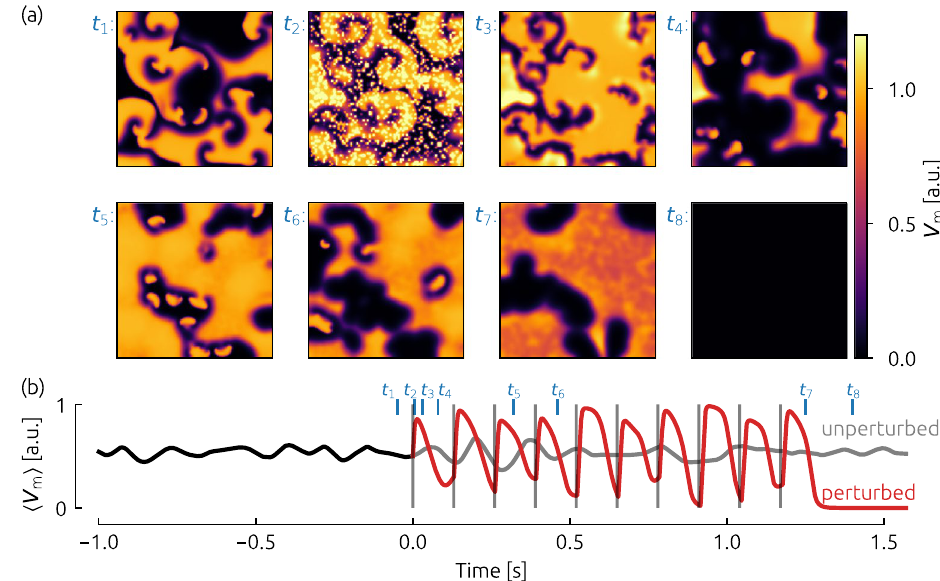
Figure 2. Exemplary (successful) termination attempt based on the Fenton-Karma model (FK) by a sequence of ten pulses. The frequency of the pulses in this example is equal to the dominant frequency f dom , and the amplitude of the pulses is E = 0.5 a.u. In ( a ), eight snapshots of the membrane potential are shown just before the pacing protocol starts ( t 1 ), during the pacing ( t 2 - t 6 ) and after the final pulse ( t 7 and t 8 ). The spatially averaged membrane potential (cid:31) V m (cid:30) (as a simple estimate for a pseudo ECG) is depicted in subplot ( b ), where pulses are marked with gray vertical lines and time instances which refer to the snapshots in ( a ) are marked in blue. From t = 0 s, the red curve shows the case where the pacing protocol was applied, whereas the gray curve depicts the unperturbed case.